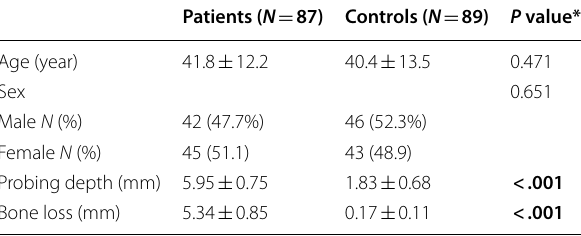
Age, probing depth and bone loss are presented as mean Analyzed with the Pearson Chi-Square test, the remaining values were analyzed with the t-test *Statistically significant values are presented in